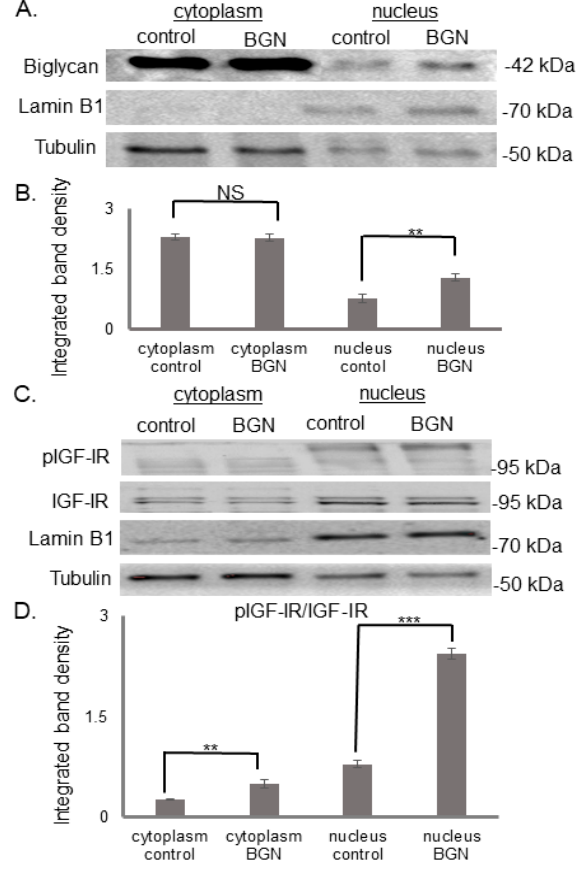
Figure 2. Effect of biglycan on its own deposition pIGF-IR protein expression at the different MG63 cell compartments. Expression of ( A ) biglycan and ( C ) pIGF-IR and in the cytoplasmic compartment of the cells treated with 0% FBS-medium (cytoplasm control) and cells treated with biglycan 10 µ g/mL (cytoplasm BGN), as well as the nuclear compartment of the cells (nucleus control; nucleus BGN) were determined by Western blot analysis. Purity controls tubulin and lamin B1 were used for cytoplasmic and nuclear proteins, respectively. Equal amounts of protein from each compartment were loaded, and ( B , D ) densitometric analysis was performed and plotted. Representative blots are presented. Results represent the average of three separate experiments. Means ± S.E.M were plotted; statistical significance: ** p ≤ 0.01, *** p ≤ 0.001, not significant (NS) compared with the respective control samples.